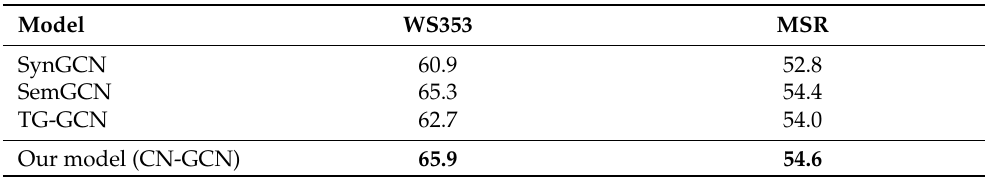
Table 2. Performance comparison of different methods using the symbolic graph on word embed- ding benchmarks. Bold indicates high